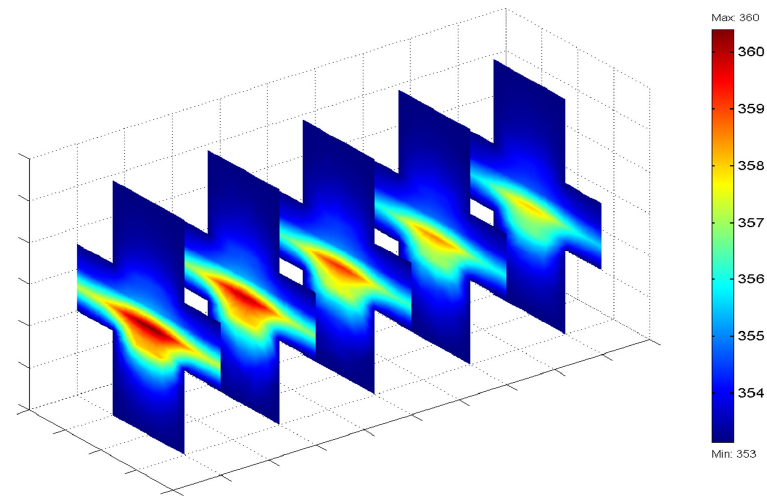
Figure 14. Temperature profile within the cell at peak